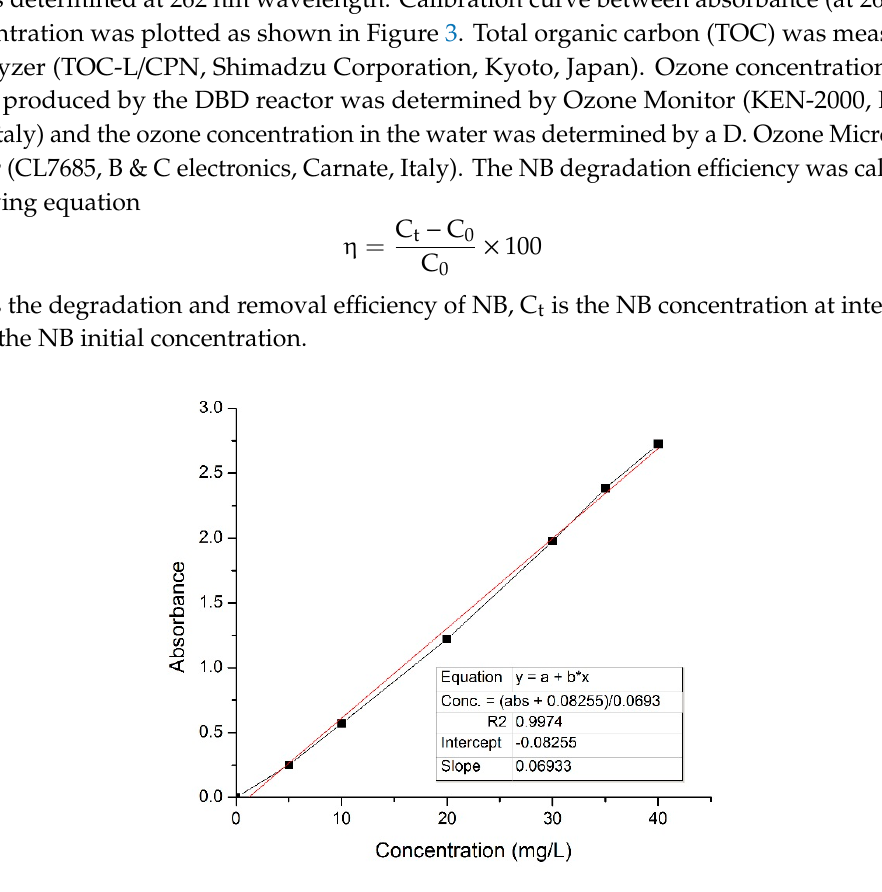
Figure 3. A plot of the calibration curve between di ff erent concentrations (at time intervals) and absorbance (at 262 nm of wavelength) values of nitrobenzene